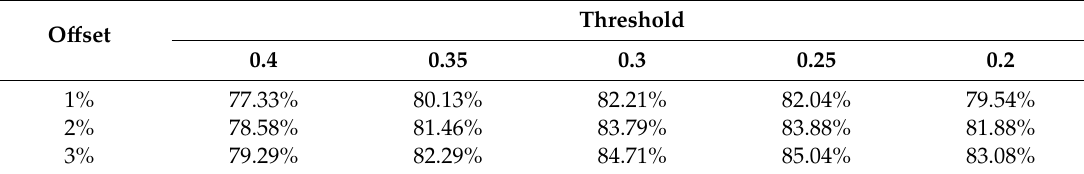
Table 3. Averaged detection probabilities of proposal 1 (window 1). Table 2. Averaged detection probabilities of conventional methods [20].